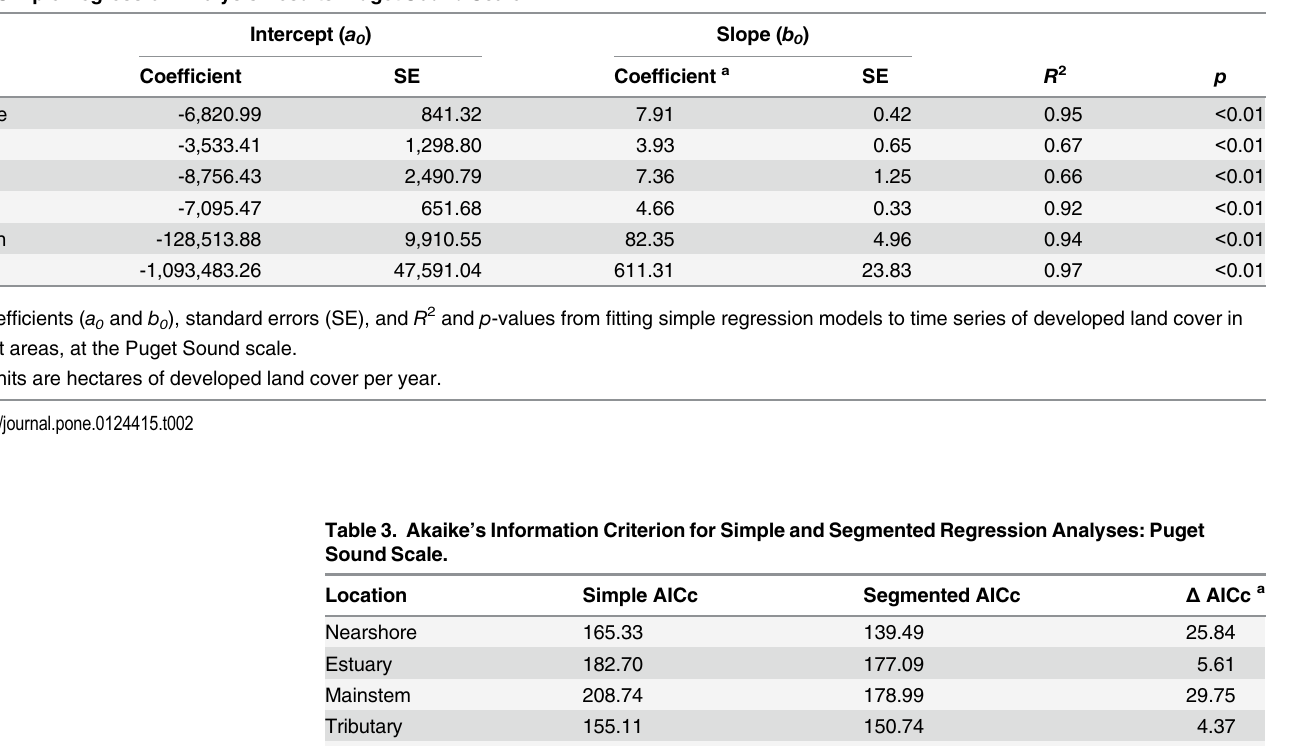
Akaike ’ s Information Criterion corrected for small sample sizes (AICc), calculated for two regression models (simple and segmented) in six habitat areas, at the Puget Sound scale. The difference in AICc (where Δ AICc = simple AICc — segmented AICc) is also provided. a Δ AICc > 4 indicates support for the segmented regression model.